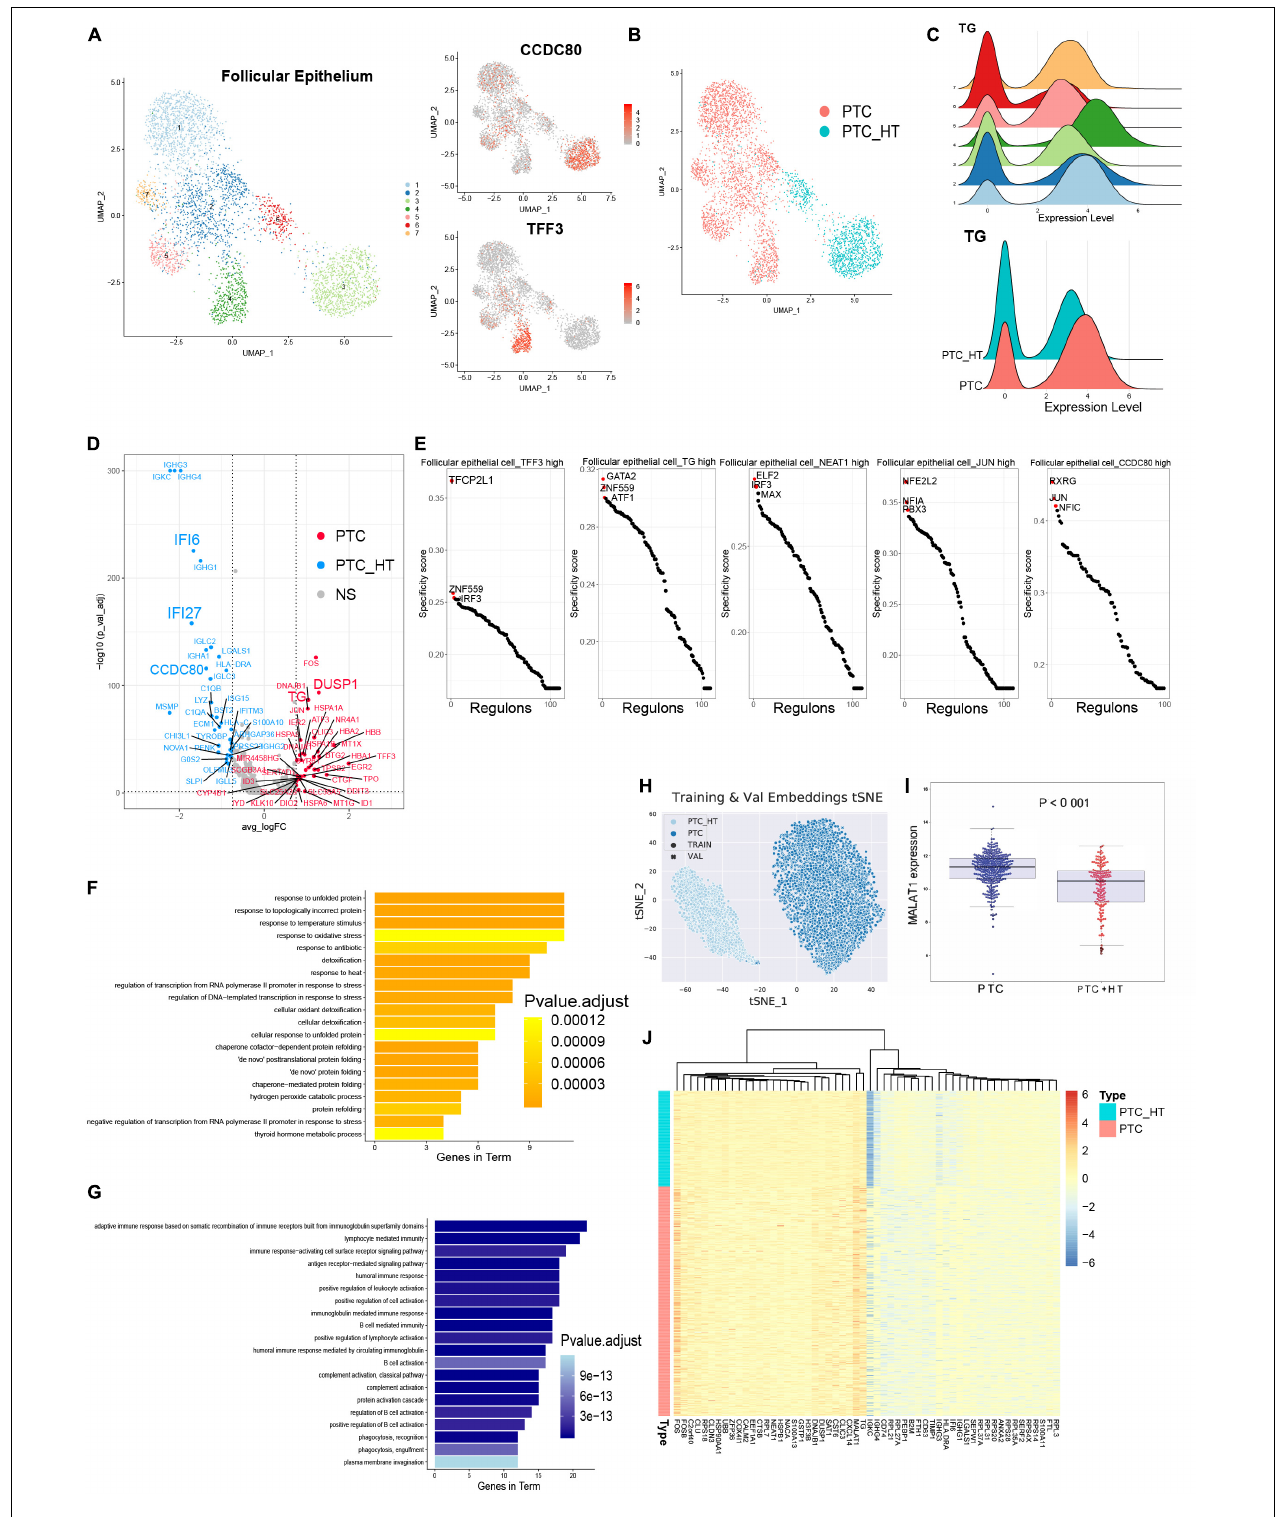
FIGURE 3 | Identifying transcriptome signatures of follicular epithelial cells. (A) UMAP plot of follicular epithelial cell subclusters and FeaturePlot of marker genes in two types of PTC. (B) UMAP plot of follicular epithelial cells colored by PTC types. (C) Density plots of TG expression levels and cell number distribution in follicular epithelial cell subclusters. (D) Volcano plot shows DEGs of epithelial cells from two types of PTC. PTC, highly expressed genes in patients without concurrent HT;